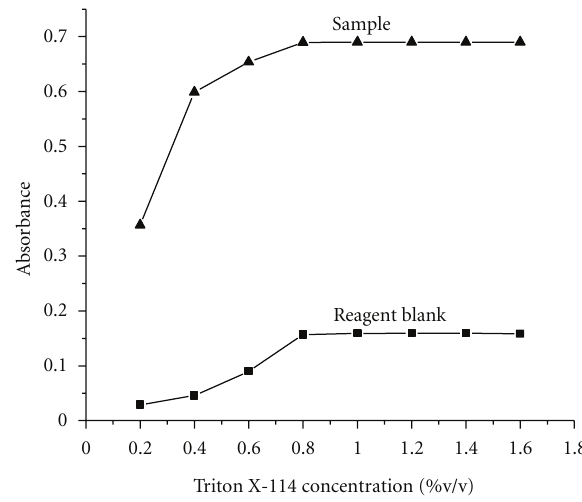
Figure 2: E ff ect of overall acidity.